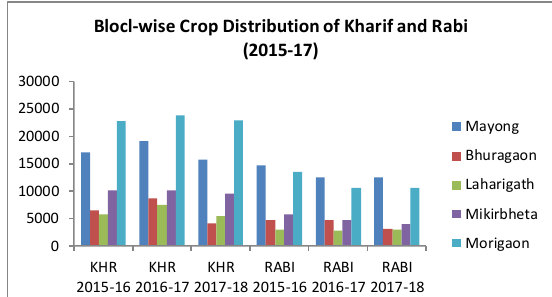
Figure 4. Block-wise crop distribution of Kharif and Rabi